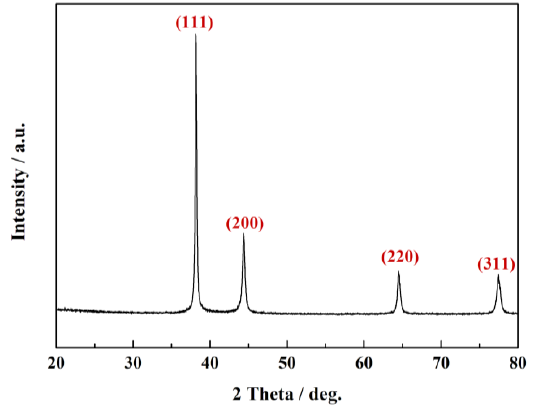
Figure 4. X-ray diffraction (XRD) pattern of the ball-like Ag nanorod aggregates.